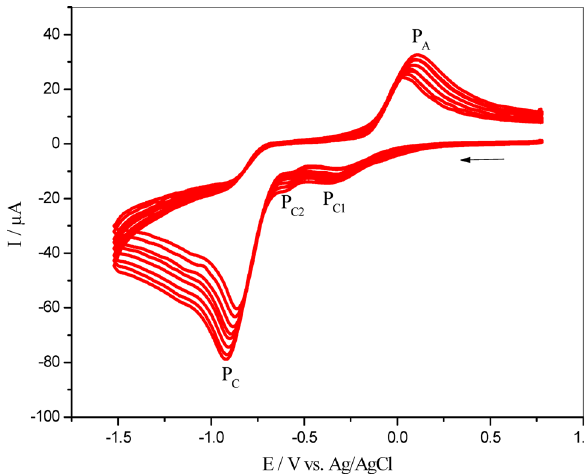
Figure 2: CVsof5.0mM o - NBAin0.1MPBS ( pH = 7.0 ) attheGQDs/CPE with a scan rate of 100mV · s − 1